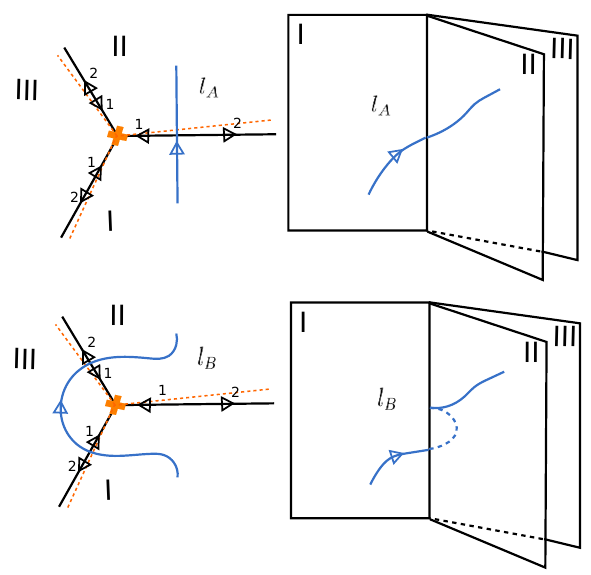
Figure 63 . The (cid:12)fth basic move in a neighborhood of a critical leaf. Here an open strand is moved across a branch point.